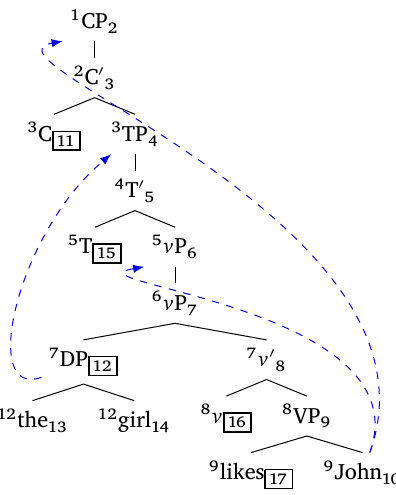
Modified recursive descent operates correctly over MG derivation